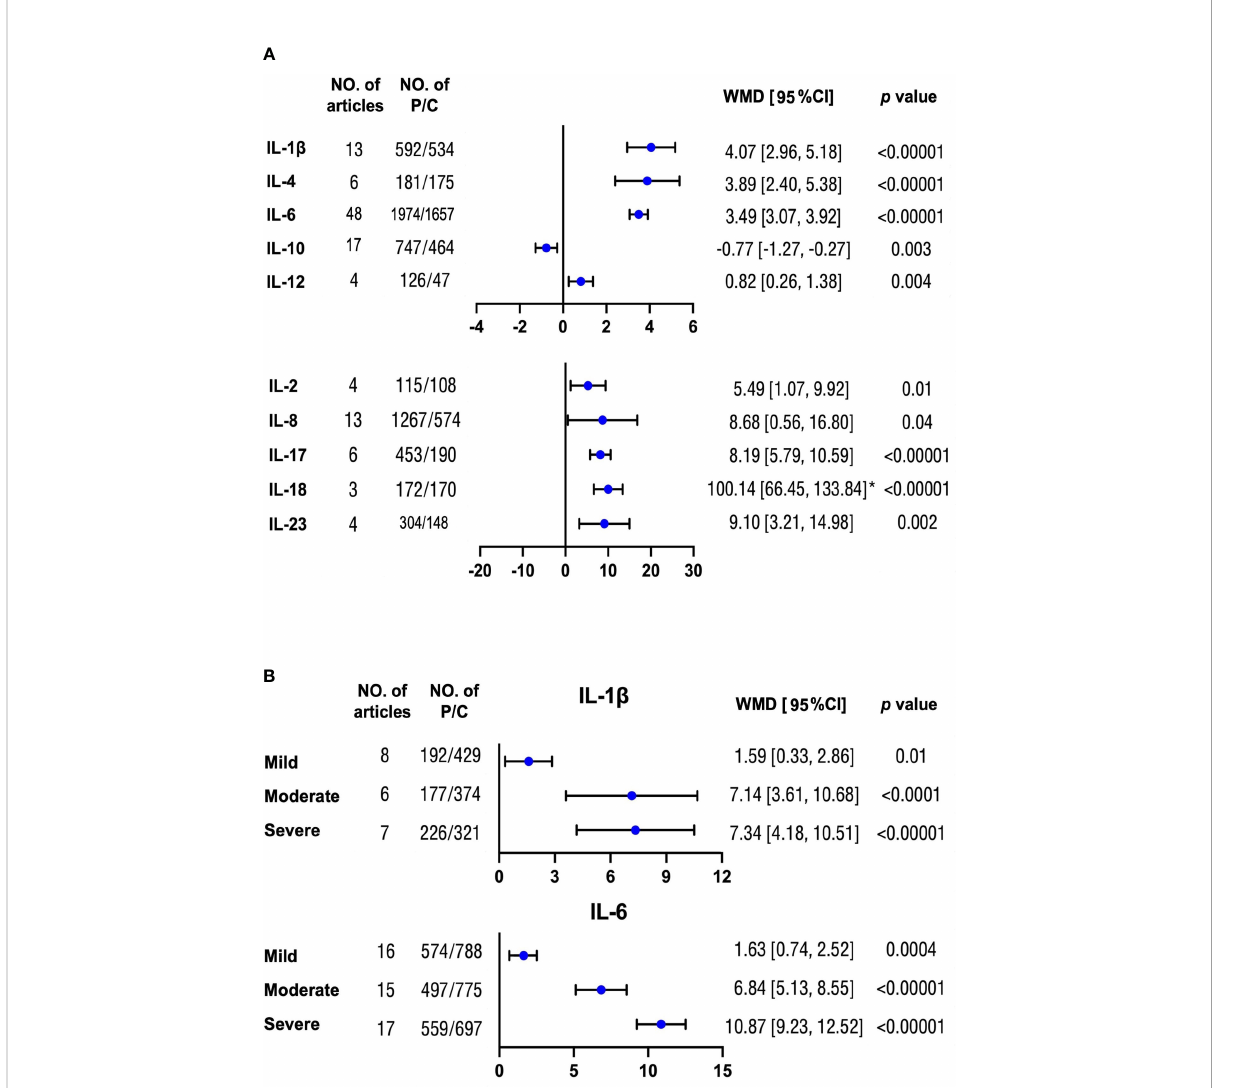
FIGURE 2 Mean differences of multiple interleukin levels between OSA and non-OSA subjects. (A) Concentration differences for several interleukin proteins were compared between patients with OSA and non-OSA controls. (B) Protein levels of IL-1 b and IL-6 were analyzed between patients with OSA with mild, moderate, and severe severity and controls, respectively. The unit for all protein concentrations was presented as picograms per milliliter. Weighted mean difference (WMD) and 95% con fi dence interval (95% CI) were used for analysis. No. of articles, number of articles included for analysis in each group. No. of P/C, number of patients with OSA (P) and controls (C) were included for each group. *: The original protein value is 10 times higher than that shown in scale. The statistically different results with p < 0.05 were shown in blue point otherwise were in black point if p > 0.05. IL: